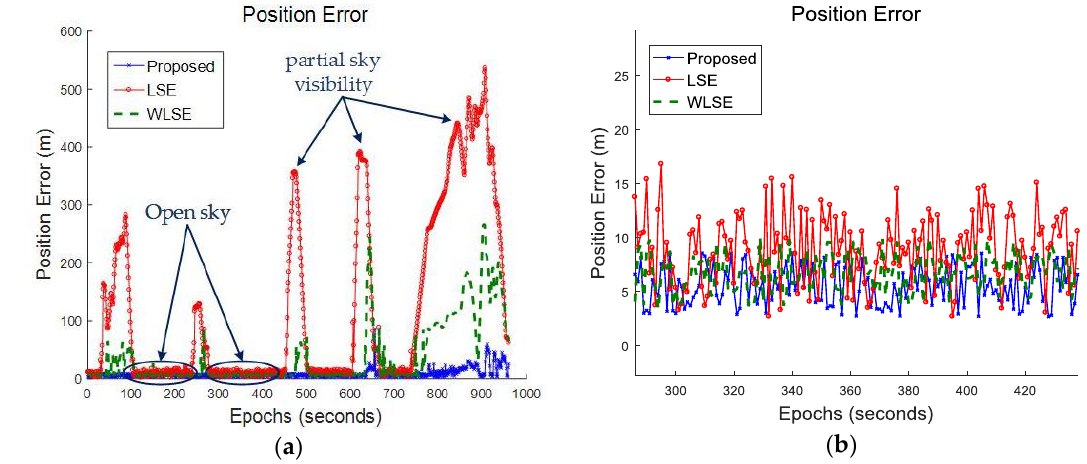
Figure 12. ( a ) Estimated position error from three algorithms; ( b ) estimated position error during open sky region (zoomed in).